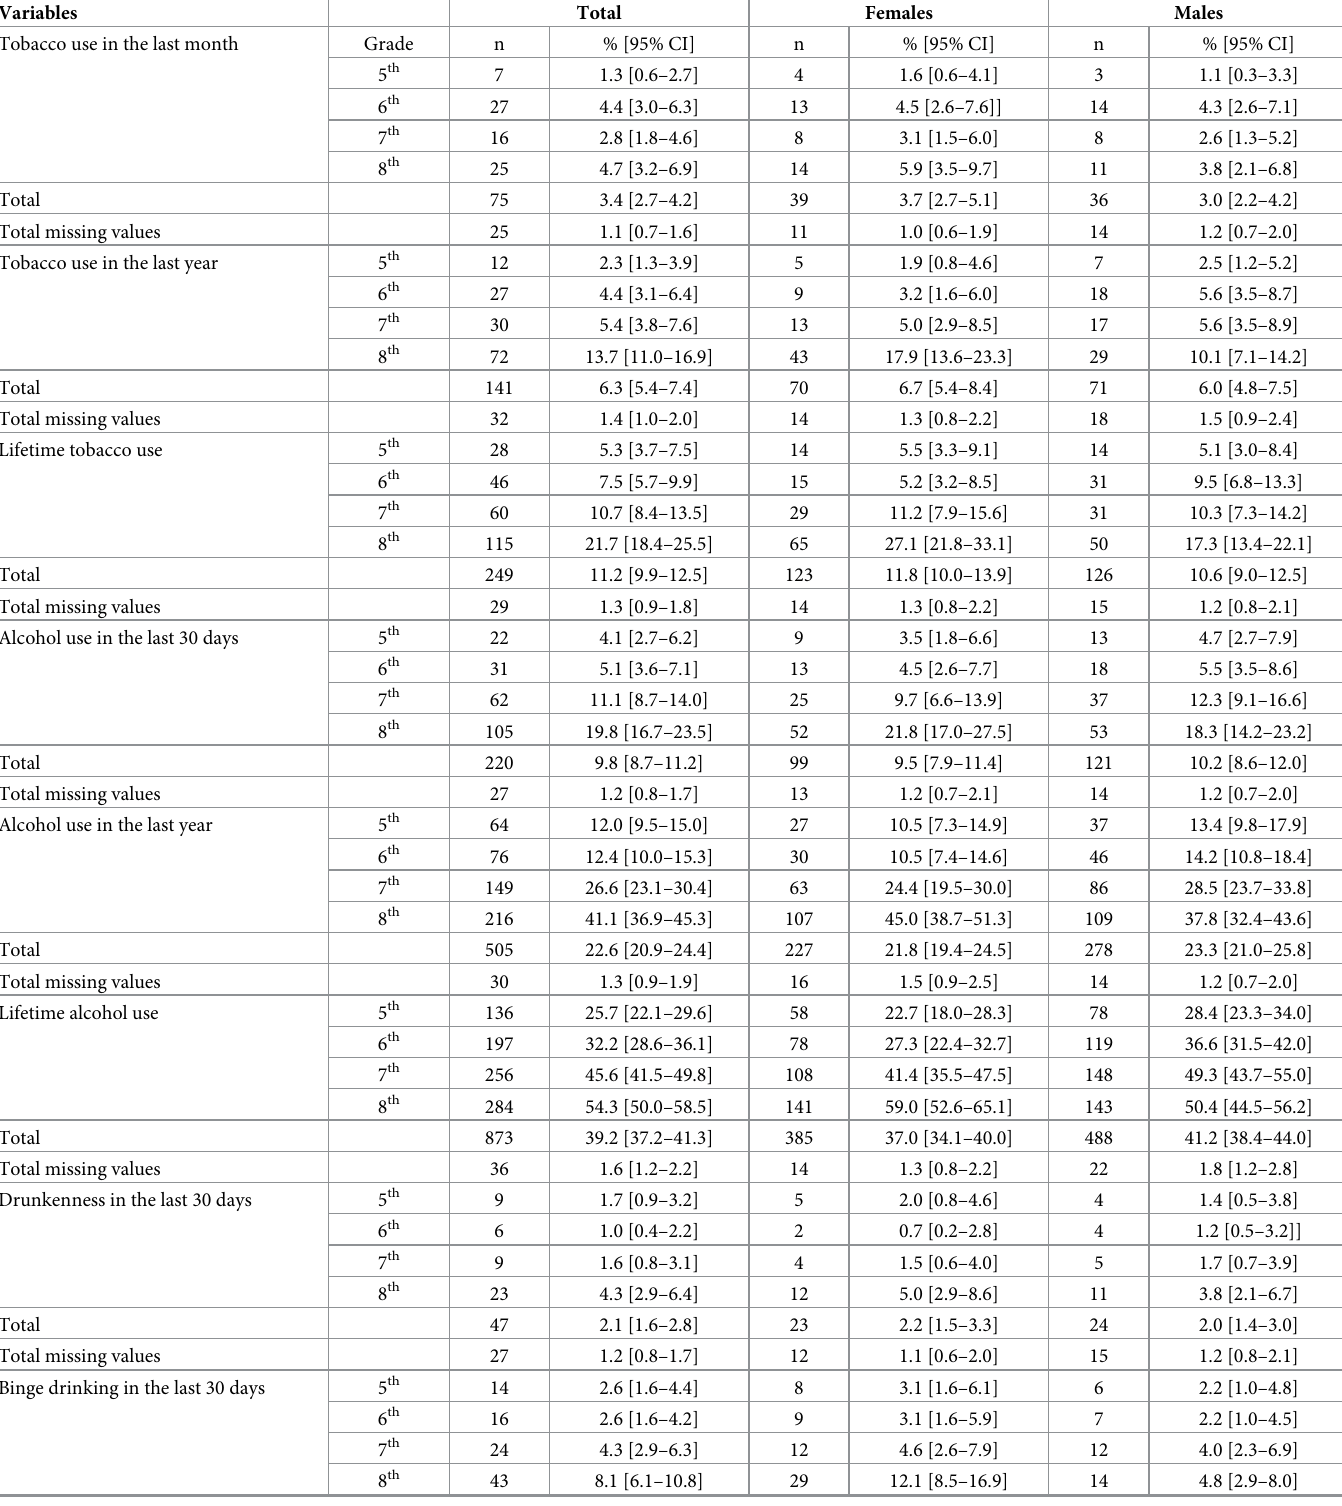
Table 2. Substance use